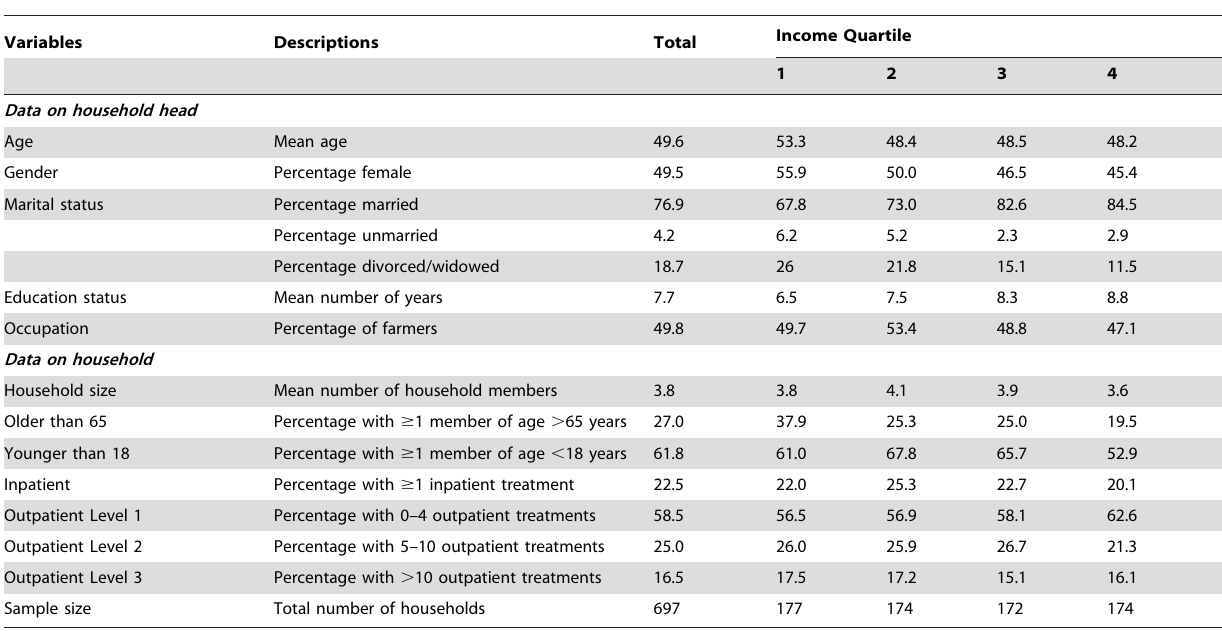
Table 1. Household characteristics by income quartile.